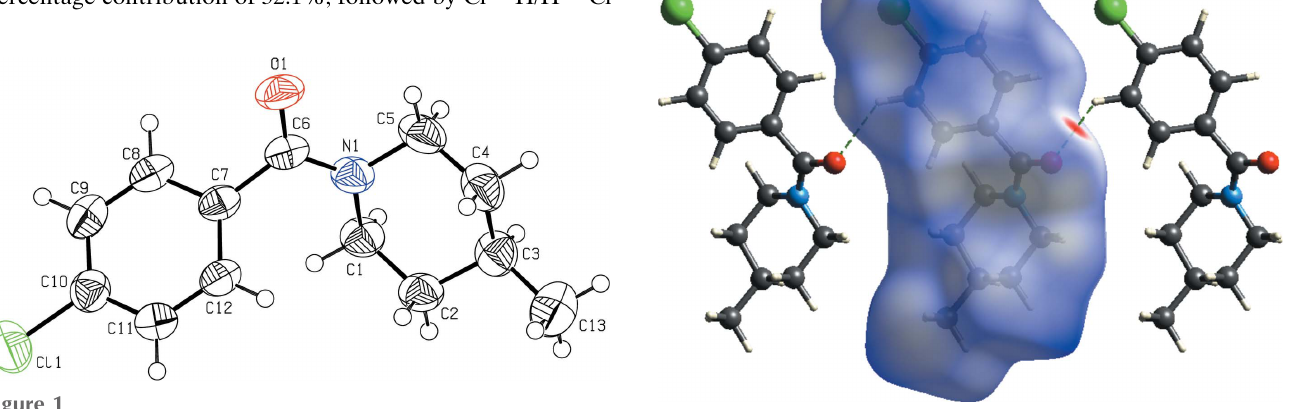
Figure 3 Hirshfeld surfaces mapped over d norm showing weak C—H (cid:3)(cid:3)(cid:3) O inter- actions on either side of the molecule.